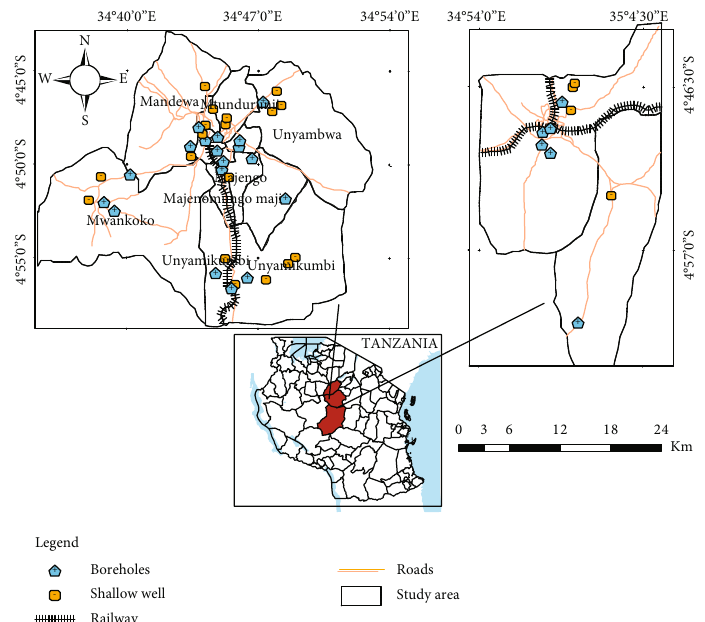
Figure 1: Map of Singida Urban and the sampling stations in the region for the shallow wells and borehole. Table 1: The measure of central tendency and Wilcox signed-rank test results for NO between the dry and wet